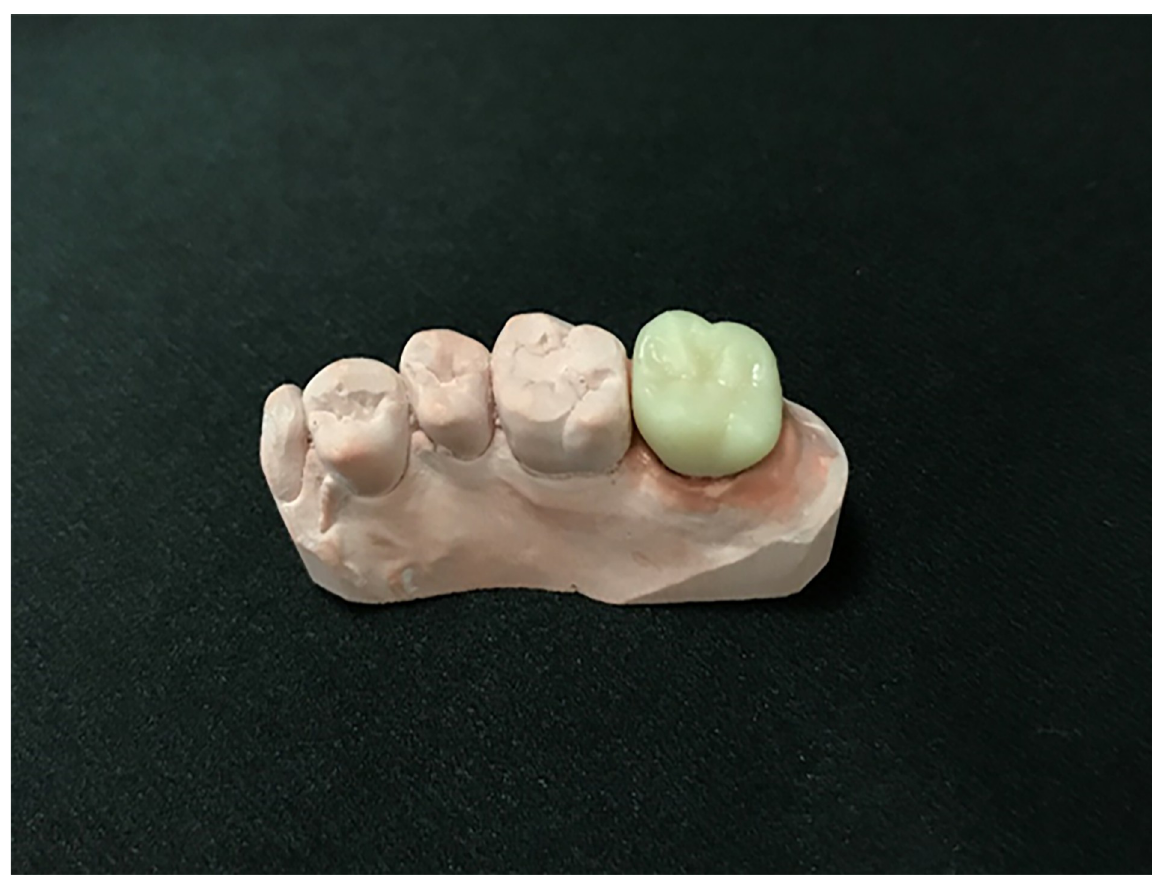
Fig 9. Fabricated interim crown with a photopolymer using a digital light-processing 3D printer.